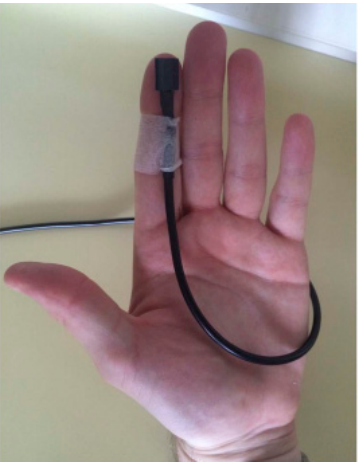
Figure 7. Response button used for answering to Detection-response task (DRT) stimuli